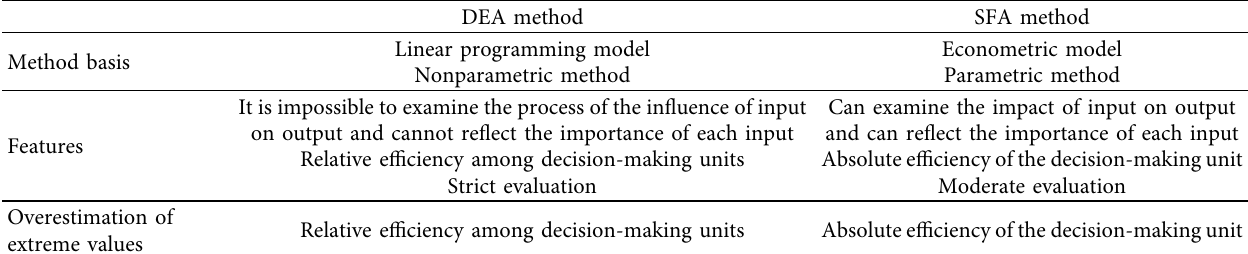
Table 2: Comparison table of DEA method and SFA